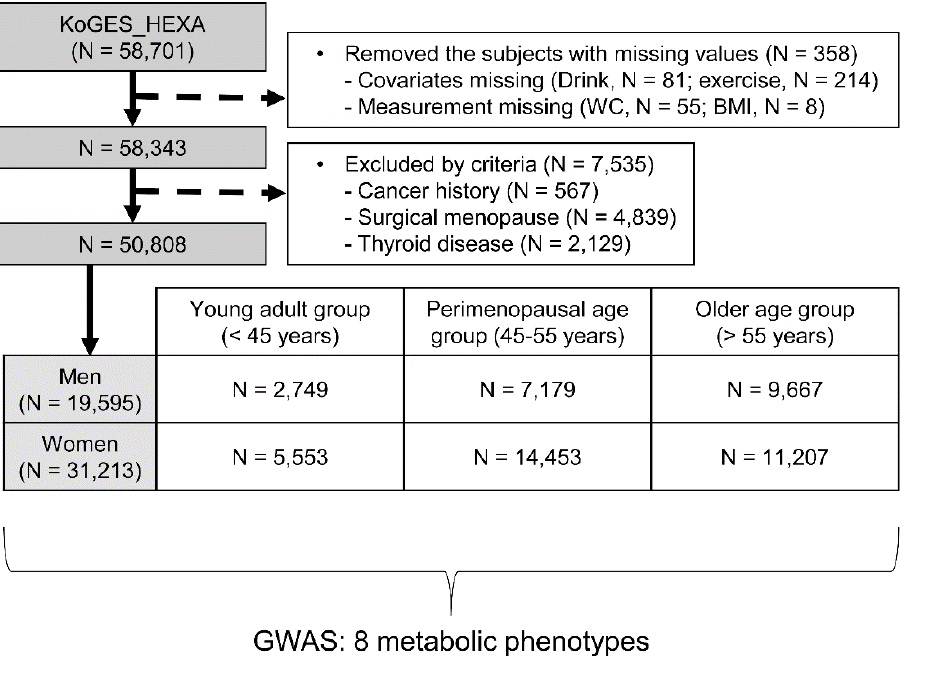
Figure 1. Flow chart of the study. The perimenopausal age group (45 – 55 years) includes perimenopausal women and perimenopause-corresponding men. KoGES, Korean Genome and Epidemiology Study; WC, waist circumference; BMI, body mass index.